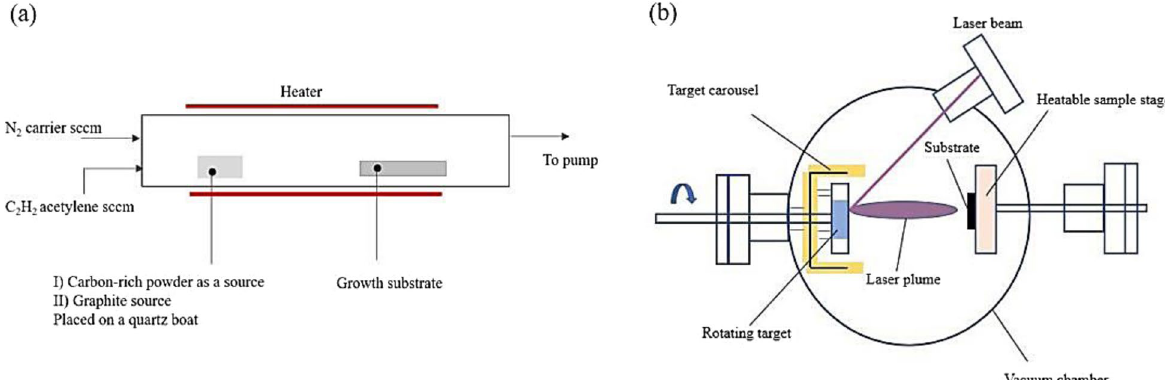
Fig. 3 The considered sources of carbon-rich materials: a CVD, either solid source or gases; b PLD [73]